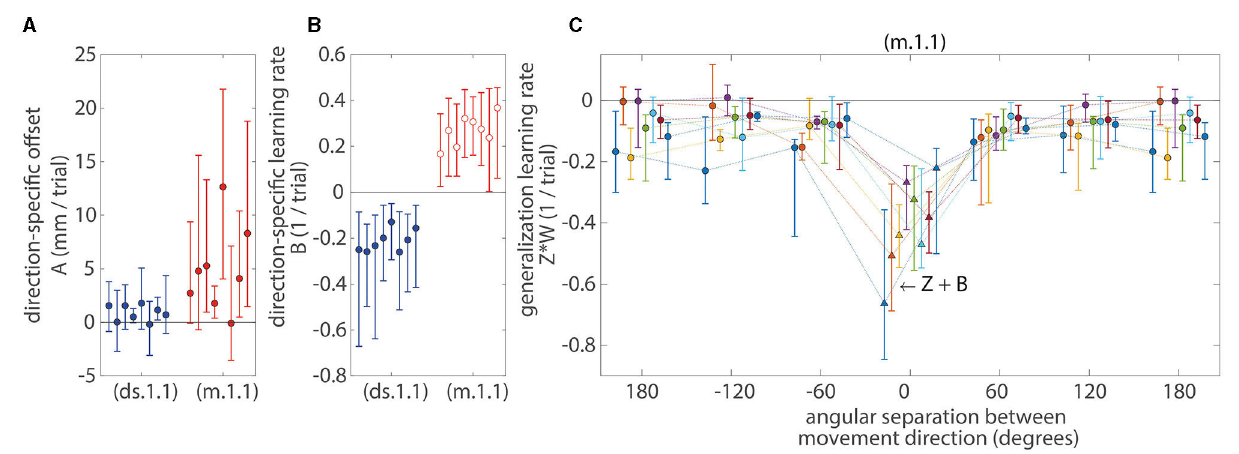
FIGURE 5 | Median parameter values for the first-order affine models. (A) The model offsets ( A value). (B) The learning rates associated with the direction-specific error (B value). (C) The effective learning rates associated with generalization across movement directions, Z * W ( θ ), see Equation (9) and (10). Markers (circles and triangles) indicate median values and error bars indicate IQR across all subjects and directions. A set of eight error bars (in all subplots and lines in C ) for each model represents eight learning tasks. The offset parameters ( A value) for both the direction-specific (ds.1.1) and mixed models (m.1.1) were significantly positive ( p < 0.05; sign-test) and were also learning task dependent ( p < 0.05; Kruskal-Wallis test). The learning rates associated with the direction-specific error ( B value) for the direction-specific model (ds.1.1) were significantly negative ( p < 0.05; sign-test) and were also learning task dependent ( p < 0.05; Kruskal-Wallis test). When memory for a movement direction could update for the mixed model (m.1.1) during the trial when that particular movement direction was practiced (i.e., W B value; triangles) were significantly negative ( p < 0.05; sign-test). However, when memory for a movement direction could update using the momentum rates ( Z + method for the mixed model (m.1.1) during the trial when that particular movement direction was not practiced (i.e., W rates ( B value) were significantly positive ( p < 0.05; sign-test). The presence of these positive learning rates indicates that there were error increasing processes (e.g., forgetting or unlearning). For the mixed models (m.1.1), the effective learning rates associated with the generalized error ( Z * W ) were more negative at zero degrees of angular separation between movement directions but became less negative as the angular separation increased to 60 degrees or more. These learning rates were symmetric across positive and negative (clockwise and counterclockwise) angular distances. All effective learning rates associated with the generalized error ( Z * W ) were significantly negative ( p < 0.05; sign-test) and were learning task dependent at 120 and 180 degrees of angular distances ( p < 0.05; Kruskal-Wallis test).